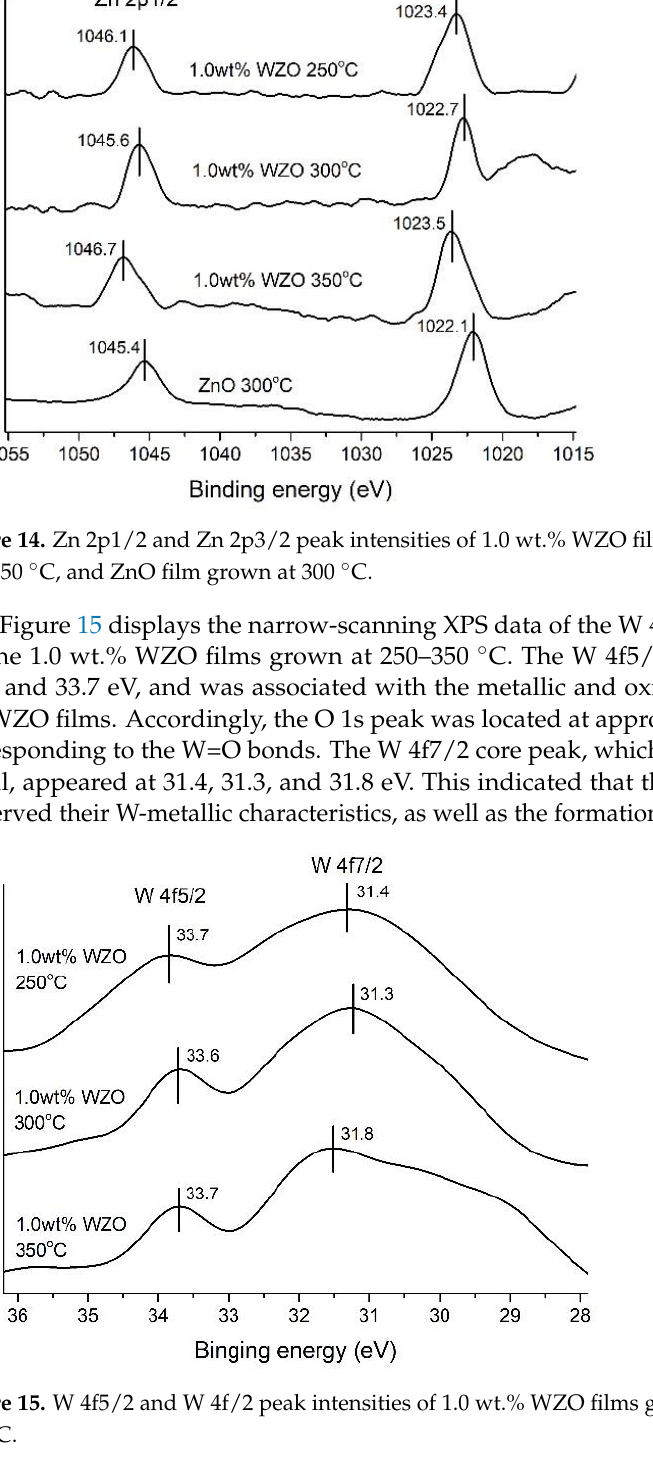
Figure 15. W 4f5/2 and W 4f/2 peak intensities of 1.0 wt.% WZO films grown at 250 °C, 300 °C, and 350 °C. 4. Conclusions In this paper, 1.0 wt.% WZO films were successfully fabricated on glass substrates under different growth temperatures (200 – 400 °C) via a pulse laser deposition technique. Investigations on their electrical properties suggested that the 1.0 wt.% WZO film grown